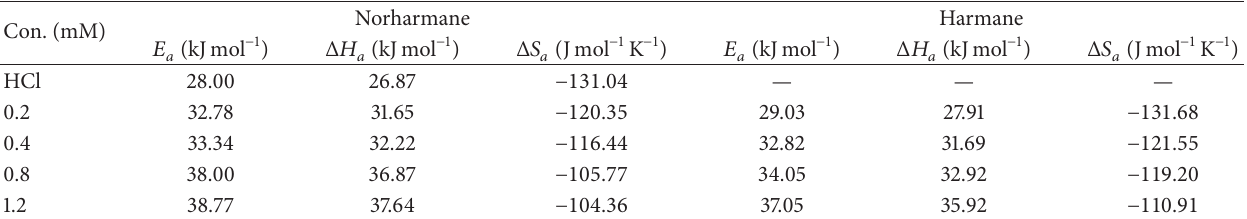
Table 6: Thermodynamic parameters calculated from IES for the adsorption of indole derivates in 1M HCl on the C38 steel at different temperatures.